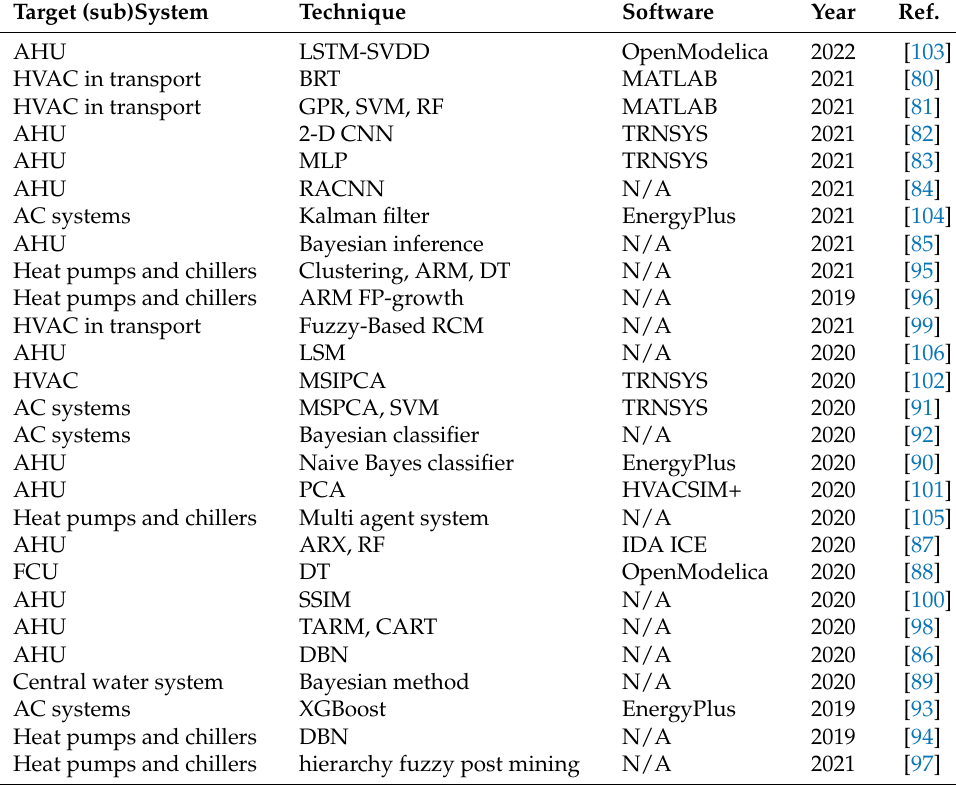
Table 7. Brief summary of related work addressing the hybrid approach in HVAC FDD. For clarity, all acronyms are provided in the Abbreviations